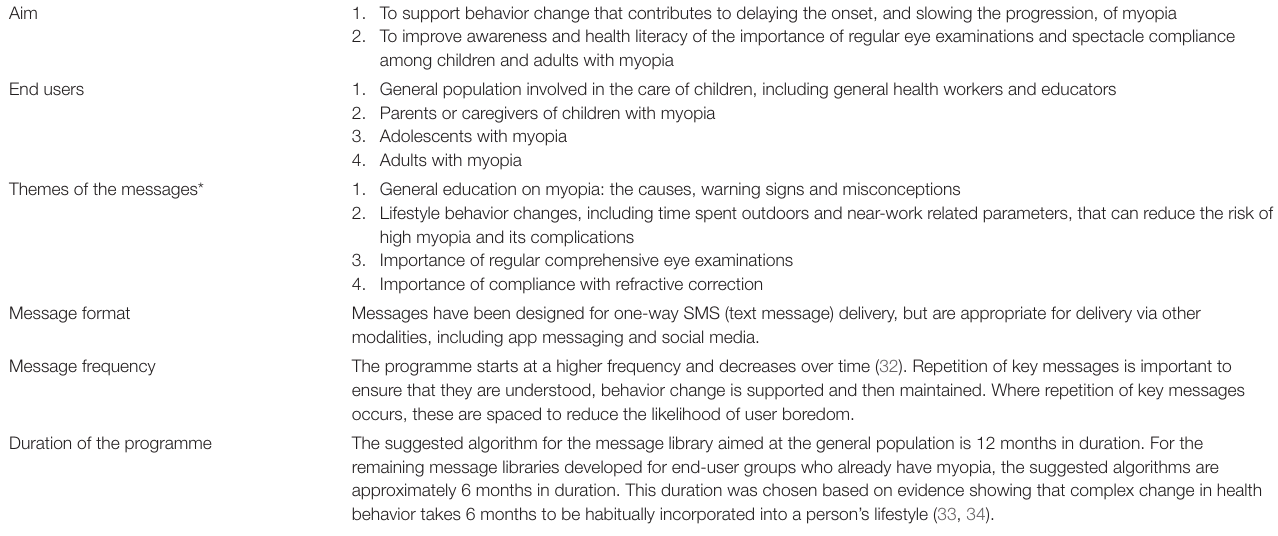
TABLE 2 | Overview of key aspects of the MyopiaEd programme (31).